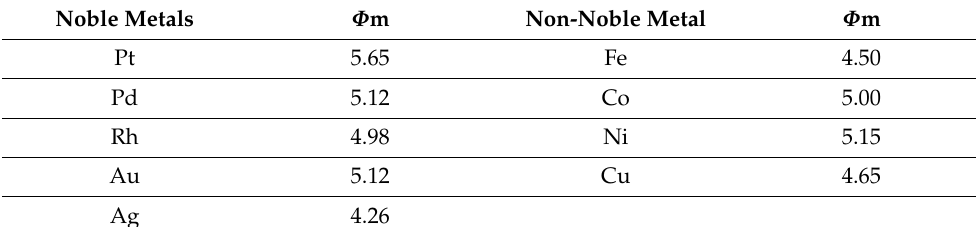
Table 1. The values of work function ( Φ m) of different noble metals and non-noble metals (eV). Noble Metals Φ m Non-Noble